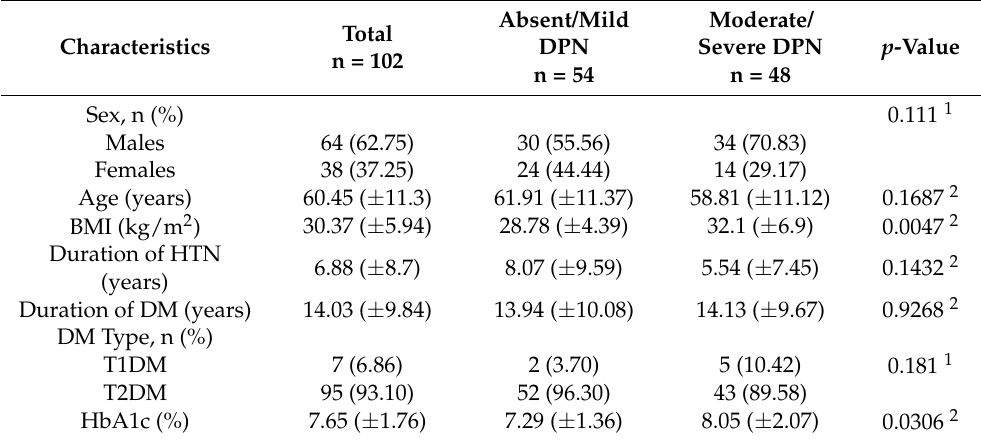
Table 1. Demographic, clinical, and biochemical characteristics of participants with diabetes. Results are shown as mean with SD in parentheses, unless indicated